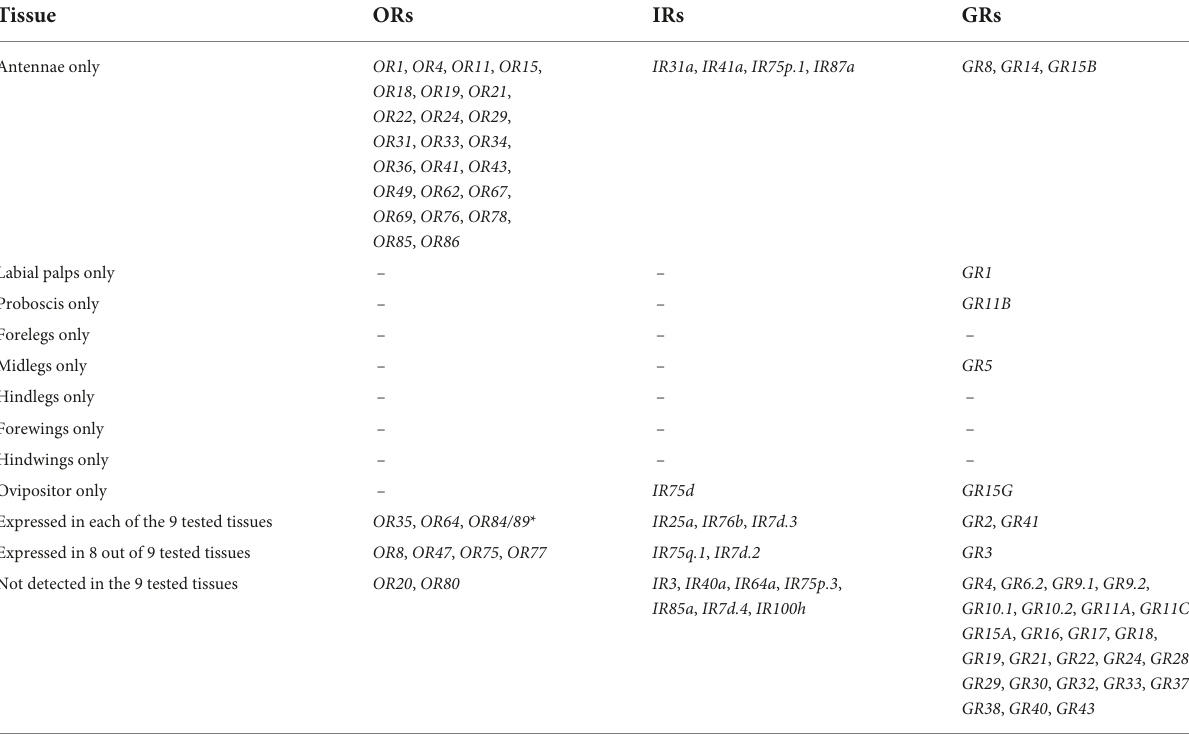
TABLE 1 Chemosensory receptor gene transcripts that were tissue-specific, broadly expressed or not detected.